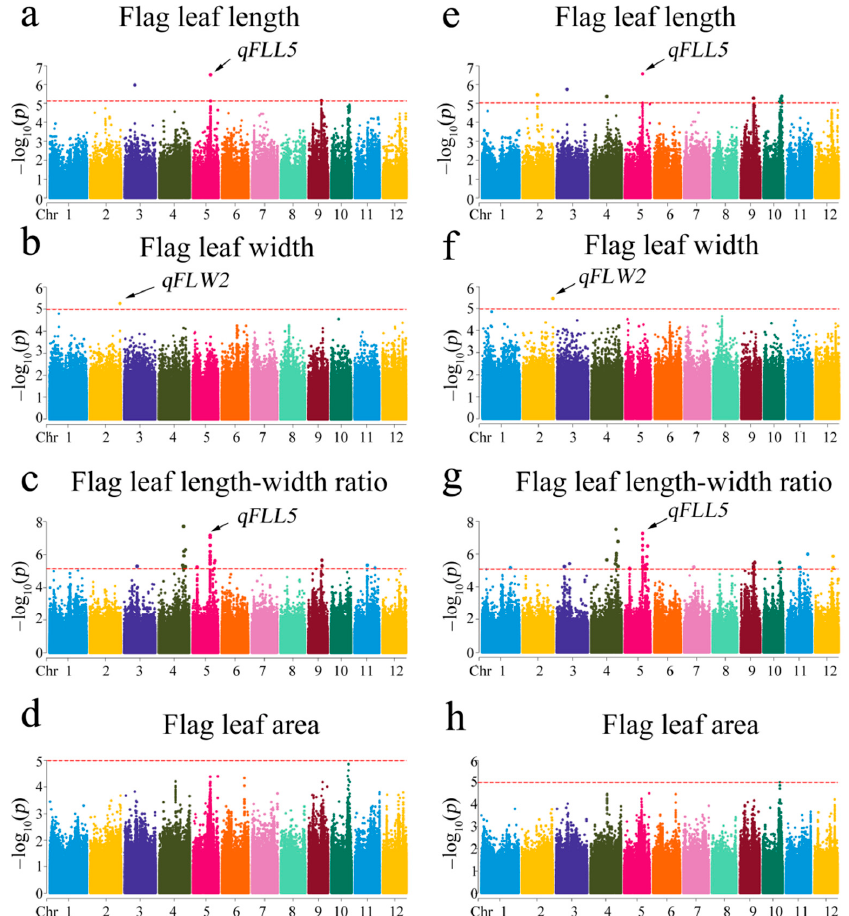
Figure 5. Manhattan plots of the genome-wide association studies for FLL, FLW, FLR, and FLA with MLM: ( a ) Manhattan plot for FLL in 2019; ( b ) Manhattan plot for FLW in 2019; ( c ) Manhattan plot for FLR in 2019; ( d ) Manhattan plot for FLA in 2019; ( e ) Manhattan plot for FLL in 2020; ( f ) Manhattan plot for FLW in 2020; ( g ) Manhattan plot for FLR in 2020; and ( h ) Manhattan plot for FLA in